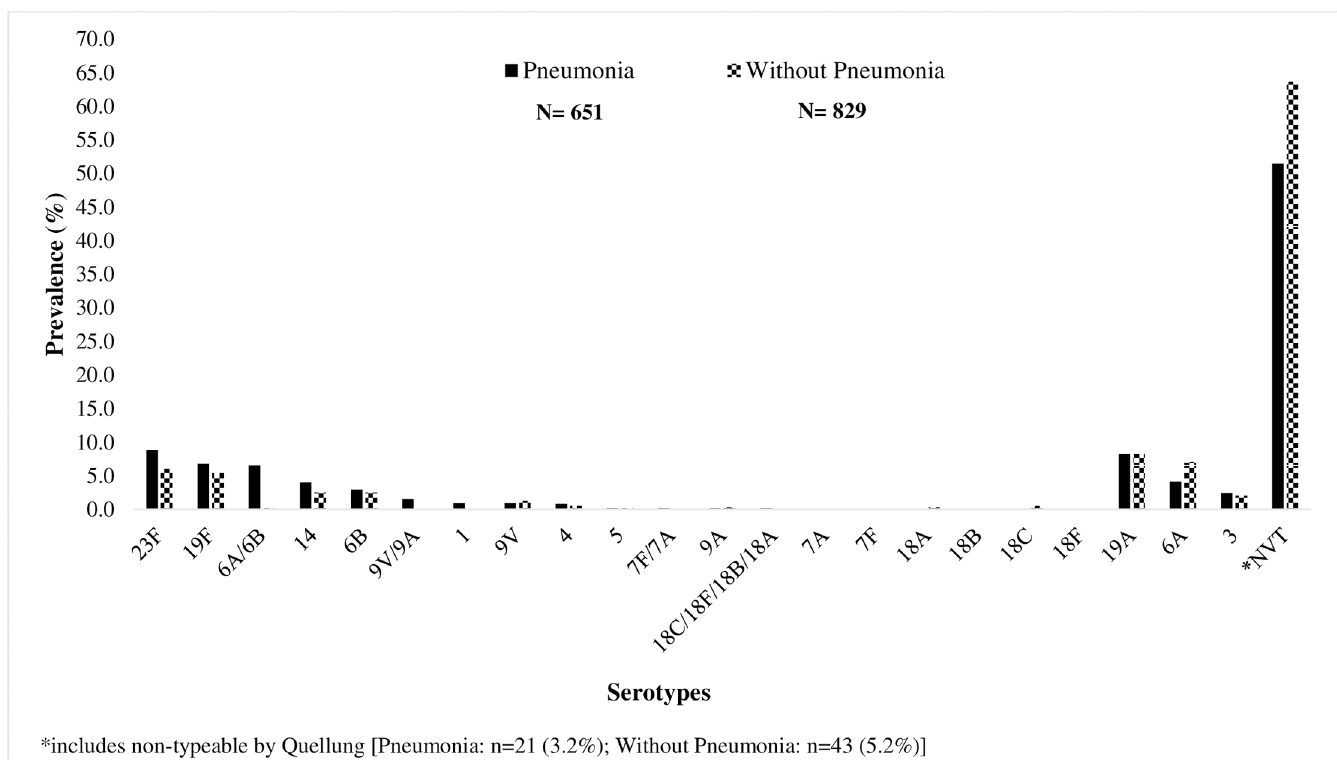
Fig 2. Distribution of serotypes among children aged < 5 years with pneumococcal colonization in Manhic¸a and Maputo, Mozambique, 2014–2016.